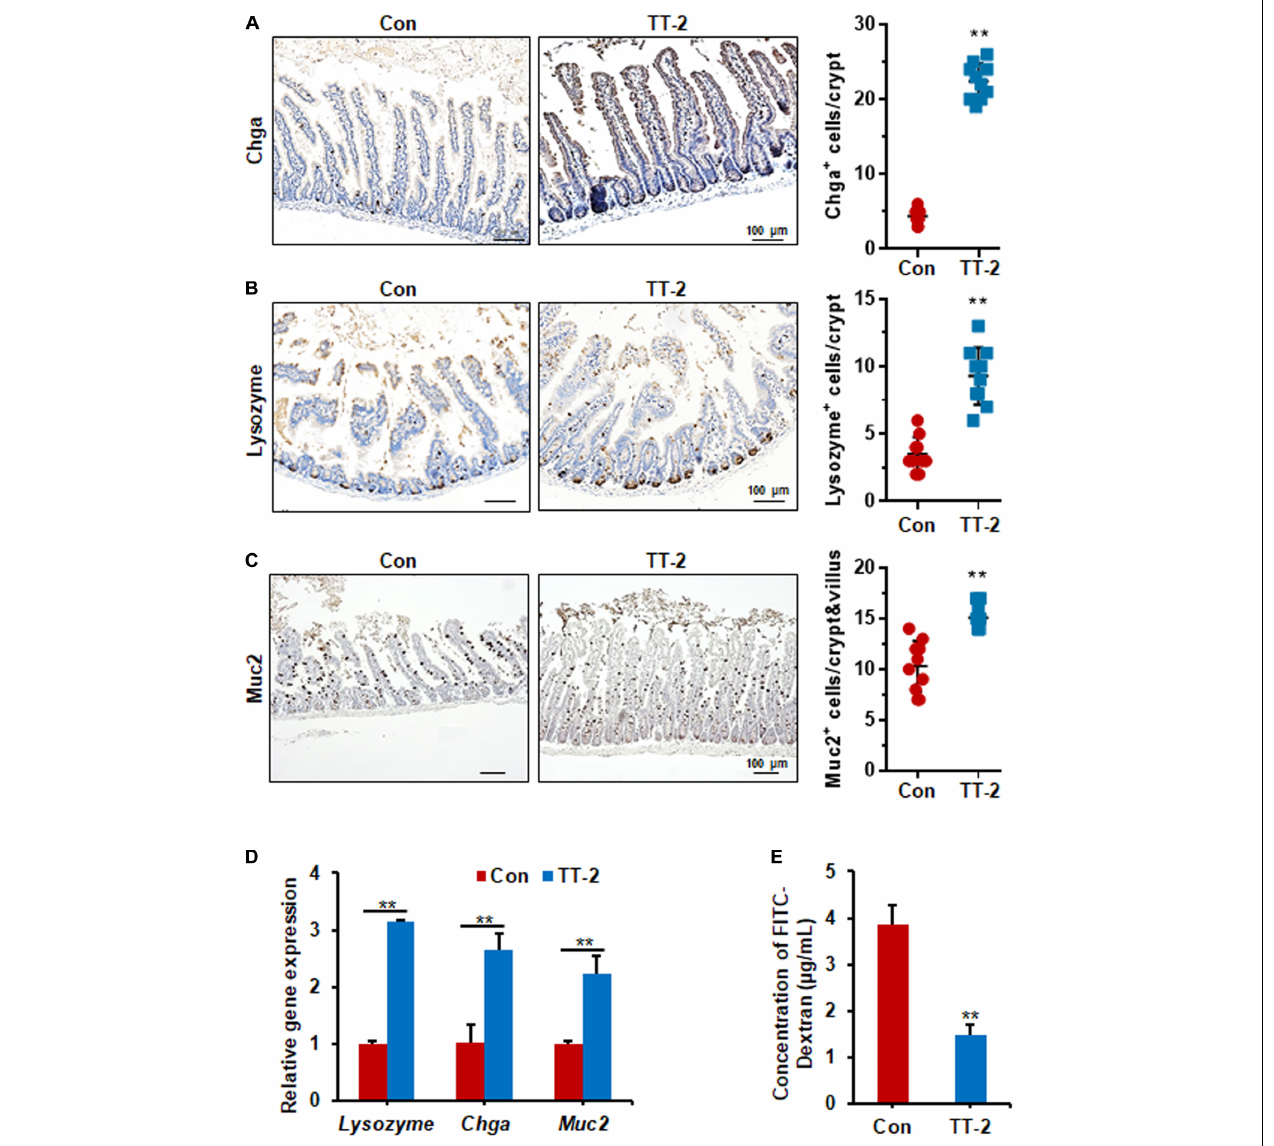
FIGURE 6 | TT-2 enhanced the integrity of intestinal epithelium of mice after 14 Gy ABI. (A) Representative Chga-stained sections and quantification of Chga + cells in crypt of small intestine after 14 Gy ABI and different treatments (** p < 0.01, scale bar = 100 µ m). Three mice from each group were used. (B) Representative lysozyme-stained sections and quantification of lysozyme + cells in crypt of small intestine after 14 Gy ABI and different treatments (** p < 0.01, scale bar = 100 µ m). Three mice from each group were used. (C) Representative Muc2-stained sections and quantification of Muc2 + cells in crypt of small intestine after 14 Gy ABI and different treatments (** p < 0.01, scale bar = 100 µ m). Three mice from each group were used. (D) qPCR for differentiation-related gene expression in mouse intestinal epithelial cells after 10 Gy irradiation with or without TT-2 treatment for 48 h (** p < 0.01). (E) The FITC-Dextran level in the serum of mice on day 4 after 14 Gy ABI and treatment with water with or without TT-2 from day − 2 to 4 (** p <